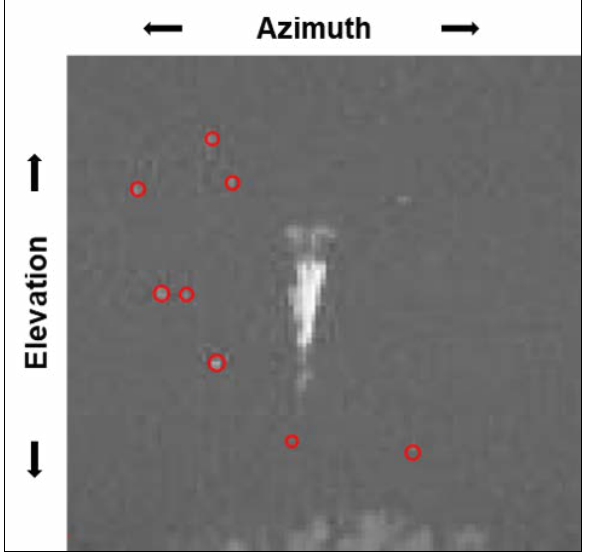
Figure 1: Sprite image with star fitting recorded on 11 January 2016 at 18:53:49.4 UTC at the South African Astronomical Observatory in Sutherland, South Africa. Red dots are the fitted